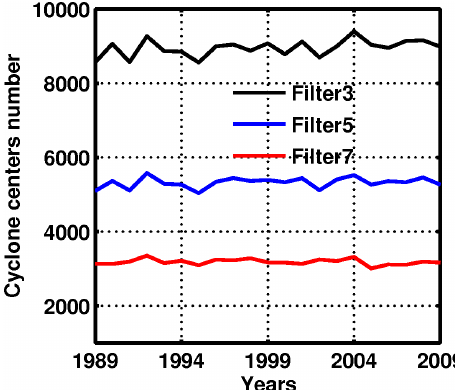
Figure 9. The number of cyclone centers per year for the three sen- sitivity